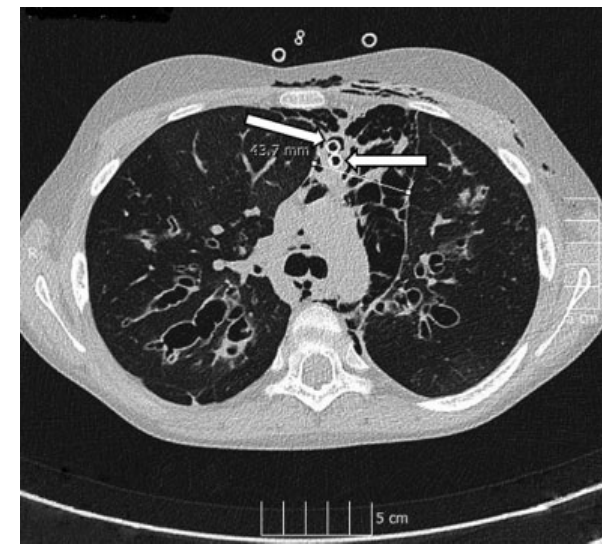
Fig. 4 Control computed tomography scan (after 11 days of the fi rst one) depicted a signi fi cant improvement (4.3cm). The arrows show the mediastinal drains.